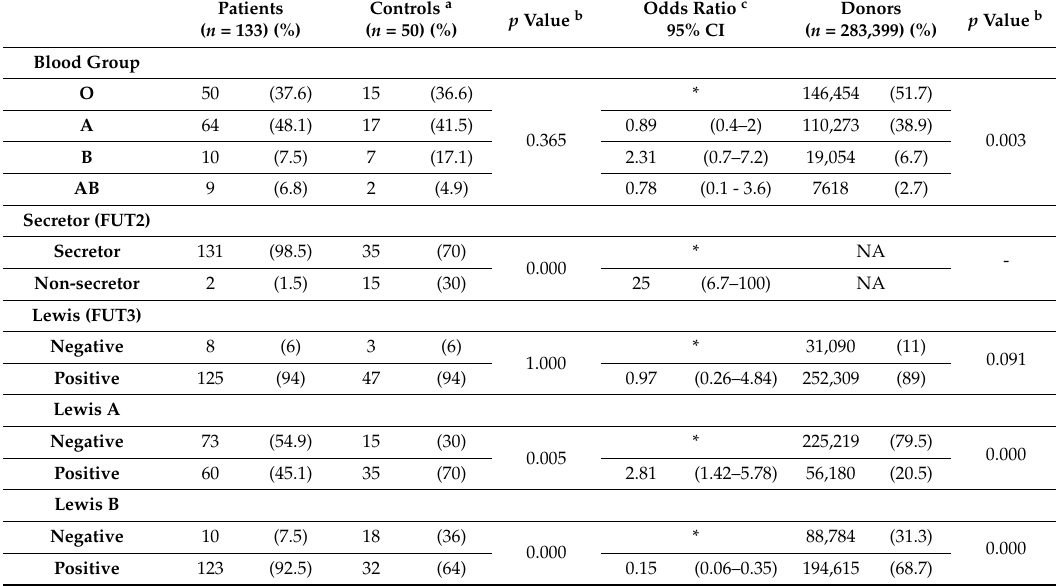
Table 1. Distribution of histo-blood group antigens (HBGAs) in rotavirus-infected children ( n = 133), in the control group ( n = 50), and in blood donors ( n = 283,399).